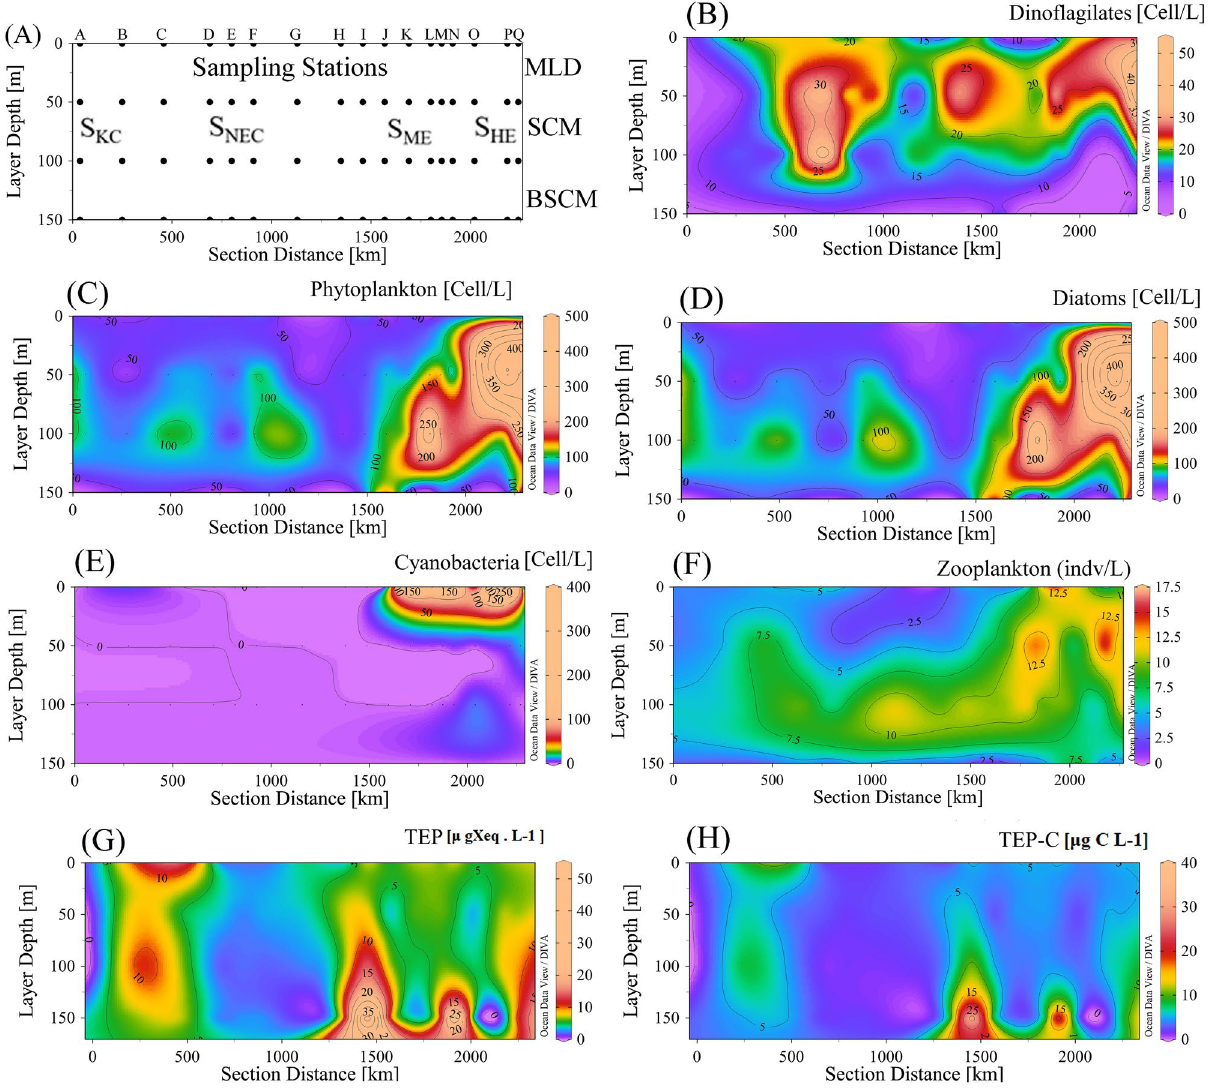
Figure 4. Segmentation of the water column, i.e., the MLD (mixed layer depth), SCM (subsurface chlorophyll maximum) and BSCM (below SCM), with station associations via geophysical forcing, i.e., S KC (stations at the Kuroshio current), S NEC (stations at the Northern Equatorial current), S ME (stations at the Mindanao Eddy) and S HE (stations at the Halmahera Eddy) throughout the study area ( A ) and vertical concentrations of biotic parameters, i.e., diatoms ( B ), dinoflagellates ( C ), cyanobacteria ( D ), TEP ( E ), TEP-C ( F ), zooplankton ( G ), and phytoplankton ( H ), in the